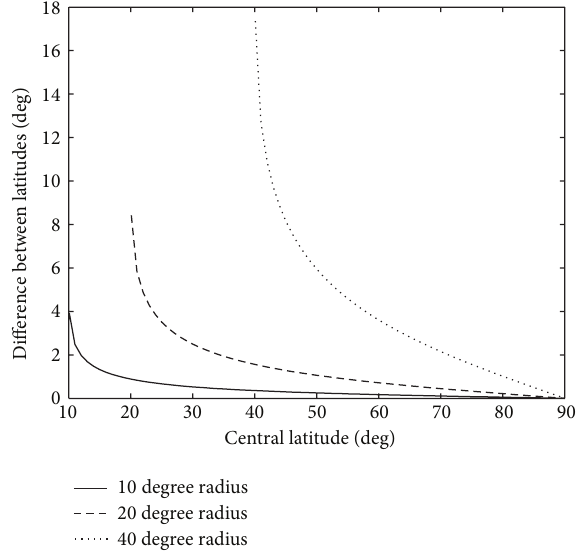
Figure 1: Differences between the optimal tangent latitude and center latitude for different